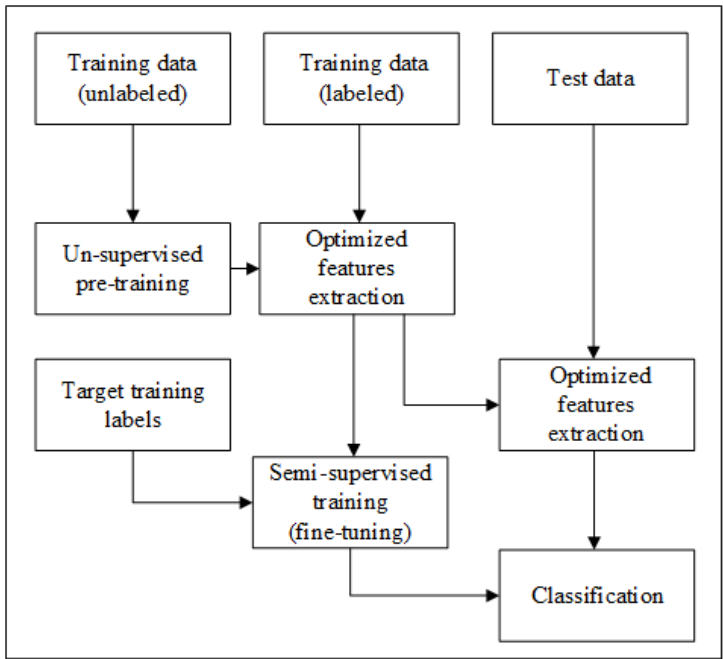
Figure 3. Complete flow of semi-supervised